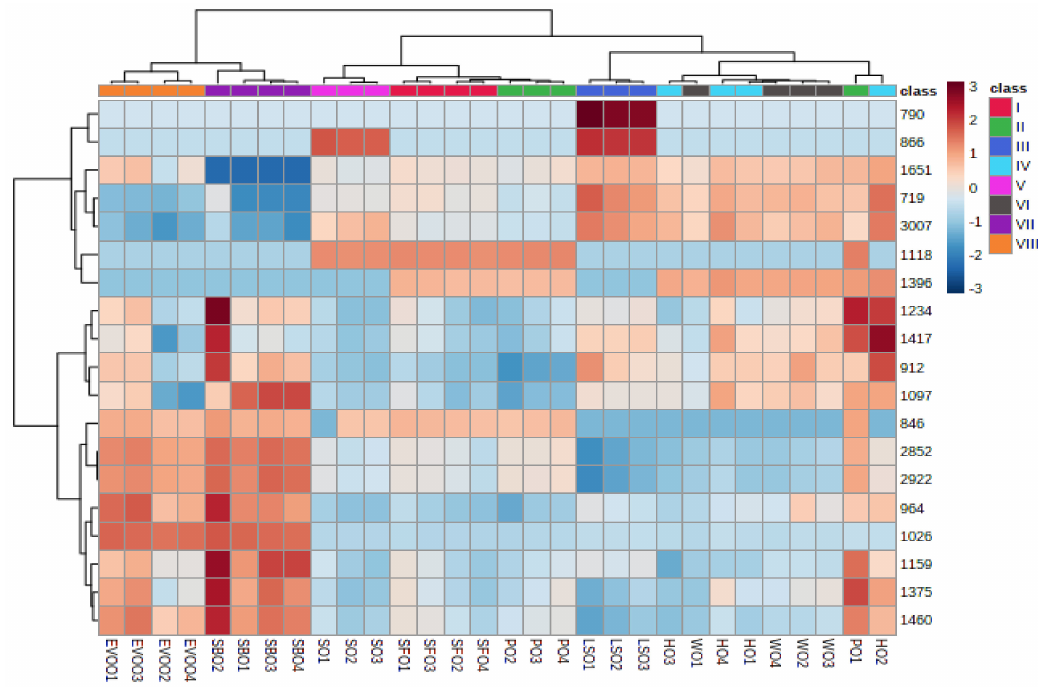
Figure 8. Heatmap showing correlations between samples and